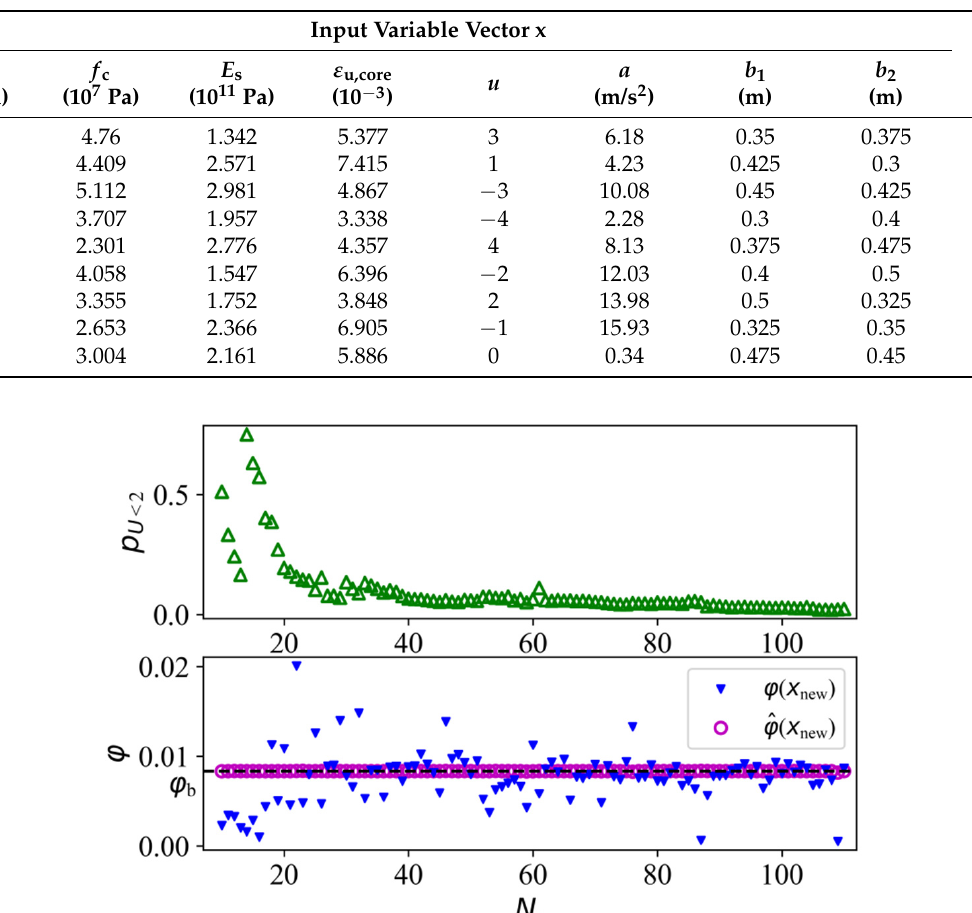
Table 6. Initial DoE of the EDP in Example 2.